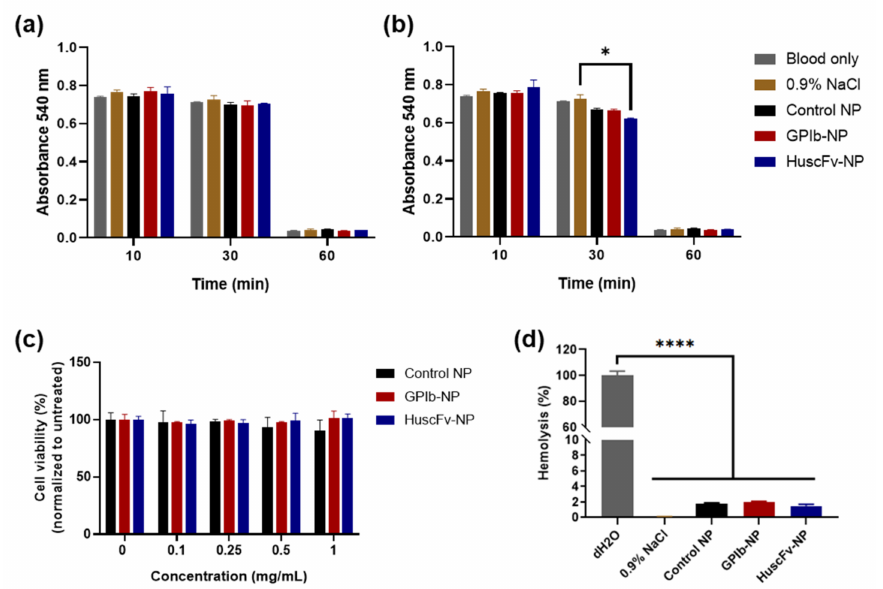
Figure 3. Cytocompatibility and hemocompatibility of NPs. Absorbance 540 nm of whole blood samples after treatment with PLGA NP samples for 10, 30 and 60 min at the NP concentrations of ( a ) 0.5 mg/mL and ( b ) 1.0 mg/mL. Normal saline (0.9% NaCl) served as negative